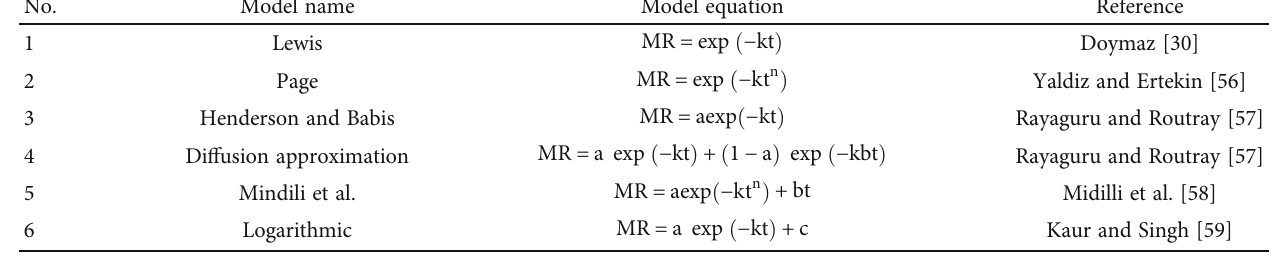
Table 2: Models and their equation considered for fi tting of experiment.